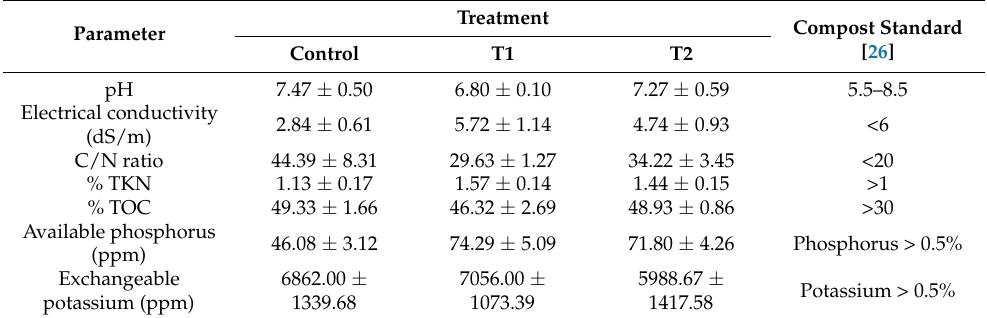
Table 3. Comparison of compost parameters in control, T1 and T2 with compost standards by the Department of Agriculture,